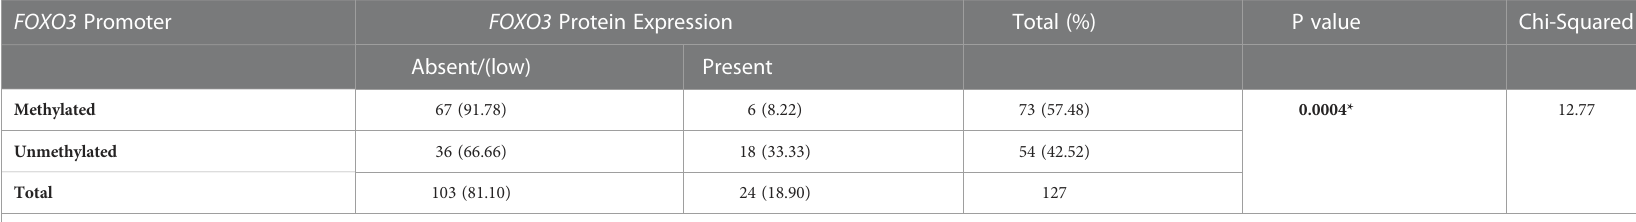
TABLE 5 Correlation study of promoter methylation with protein expression in breast cancer patients from North India.